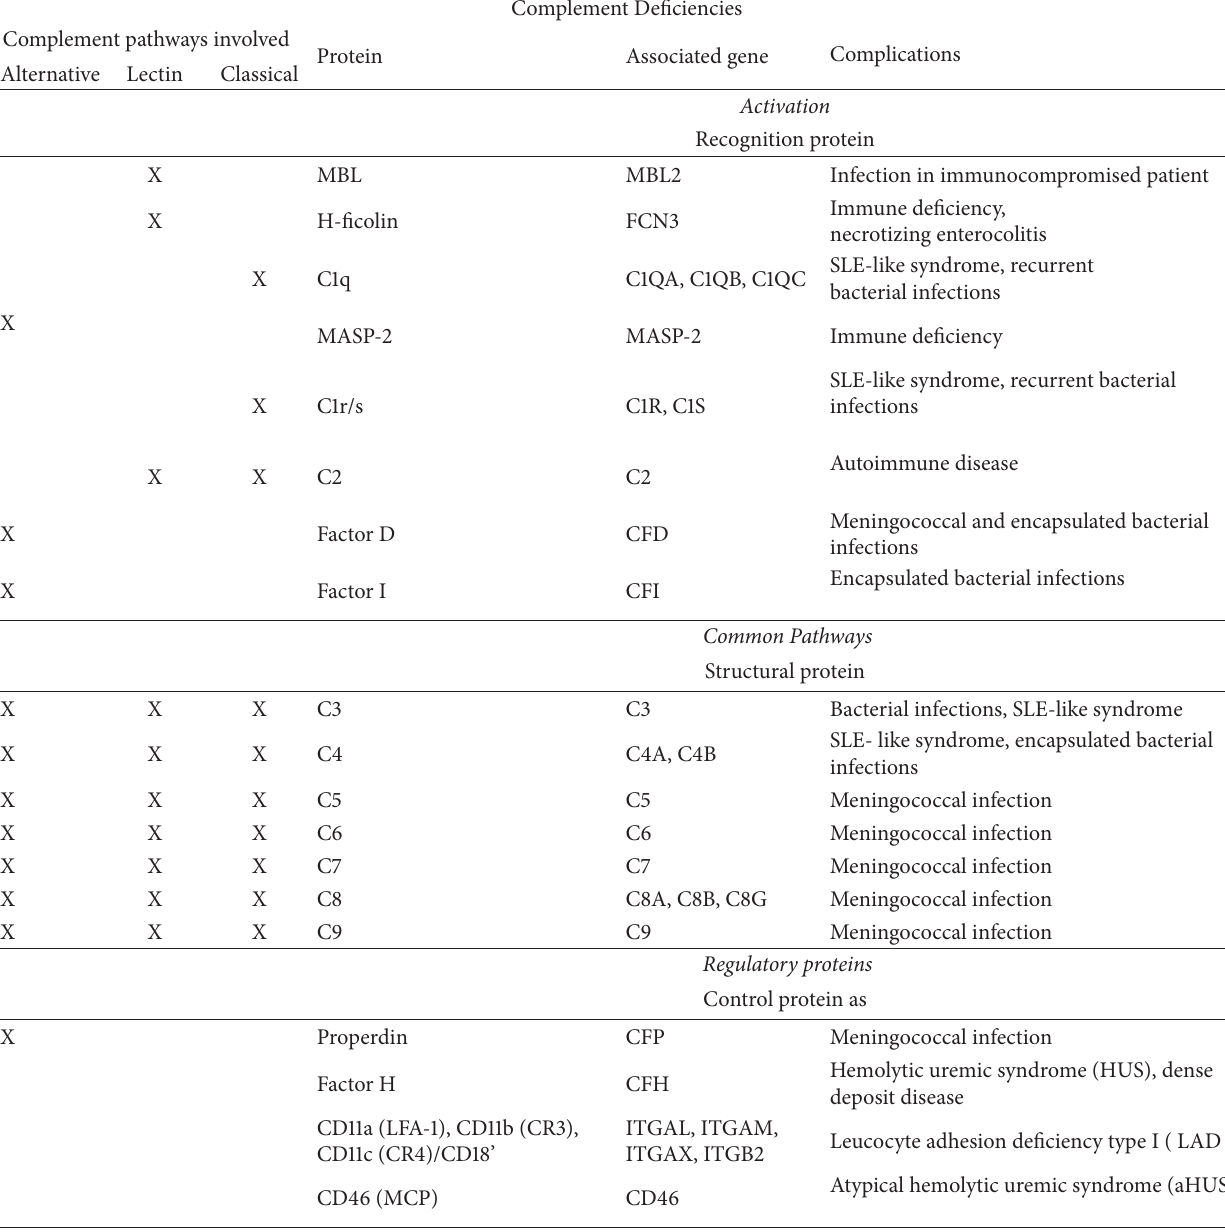
Table 2: Complement system-based therapeutics. The clinical situation, principle of anticomplement therapy, and complement-based treatment are